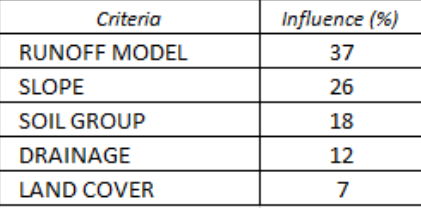
Table 2. Updated criteria for weighted overlay analysis and their corresponding influence